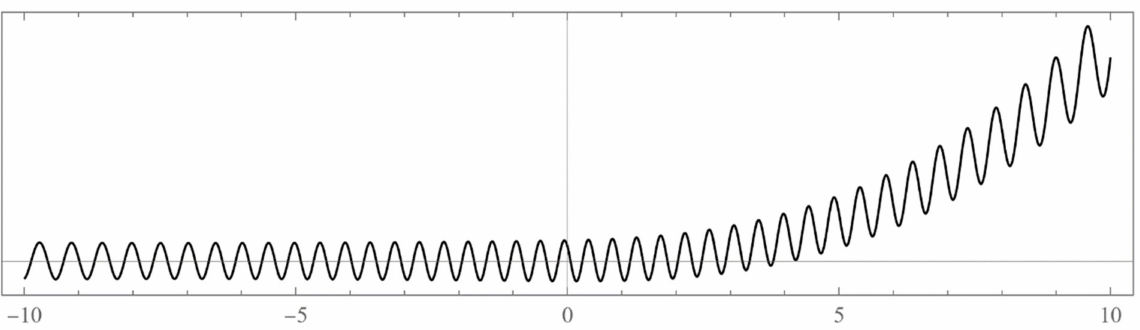
Figure A5. The un-normalized wavefunction (cid:101) ψ ( x , E ) for E = λ 2 , which is at the right edge of the energy band. We took N =